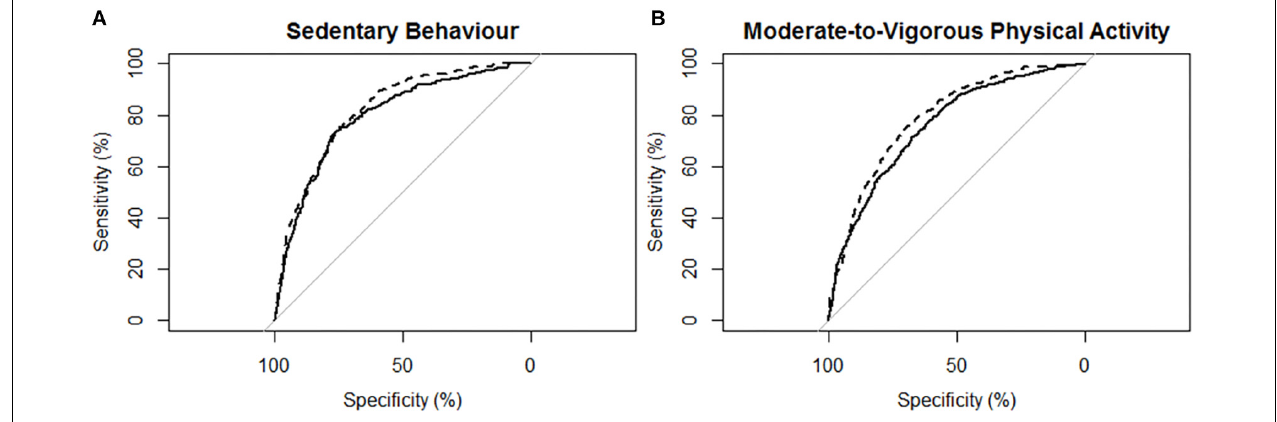
FIGURE 3 | Receiver operating characteristic (ROC) curves and corresponding area under the curves (with 95% confidence interval; AUC) for participants with mild stroke ( N = 29) with the MotionWatch8 (MW8) placed on either the non-affected side or the stroke affected side. (A) ROC curve for sedentary behavior with MW8 placed on the non-affected side (–) vs. affected side (- - -). We found there was moderate diagnostic accuracy for the non-affected side (AUC = 0.795; 95% CI: [0.766 – 0.823]), and moderate diagnostic accuracy for the affected side (AUC = 0.820; 95% CI: [0.795–0.845]). (B) ROC curve for moderate-to-vigorous physical activity with MW8 placed on the non-affected side (–) vs. affected side (- - -). We found there was moderate diagnostic accuracy for the non-affected side (AUC = 0.759; 95% CI: [0.735–0.784]), and moderate diagnostic accuracy for the affected side (AUC = 0.766; 95% CI: [0.742–0.790]).